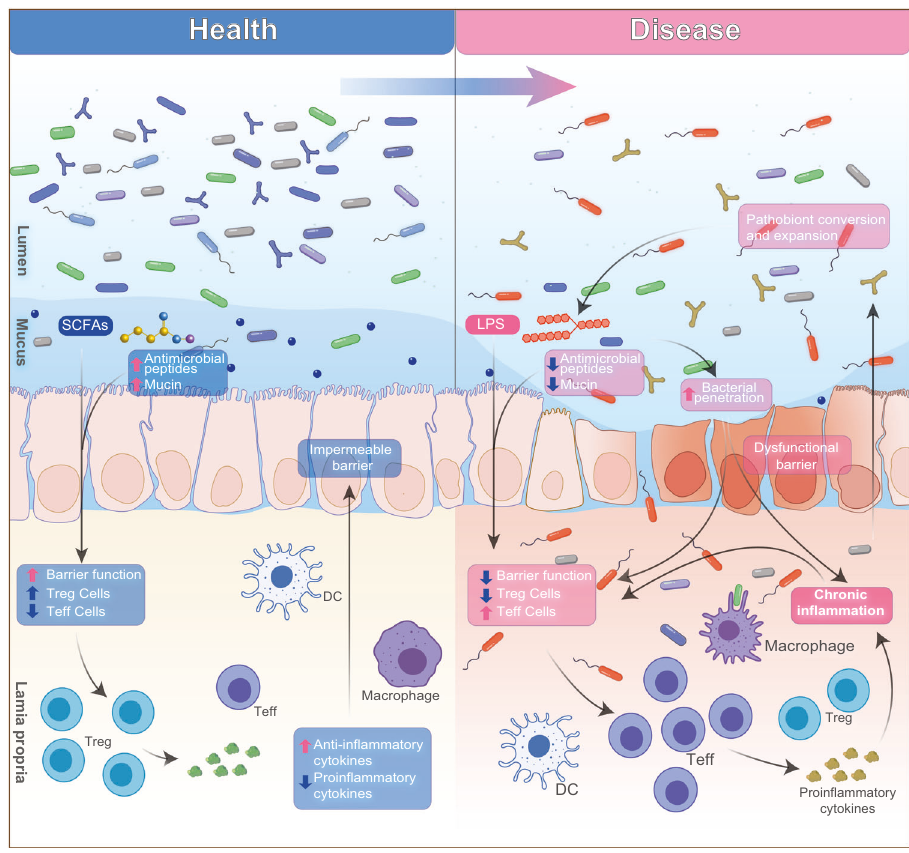
Fig. 3 Factors affecting microbiota-associated chronic in fl ammation in healthy and disease